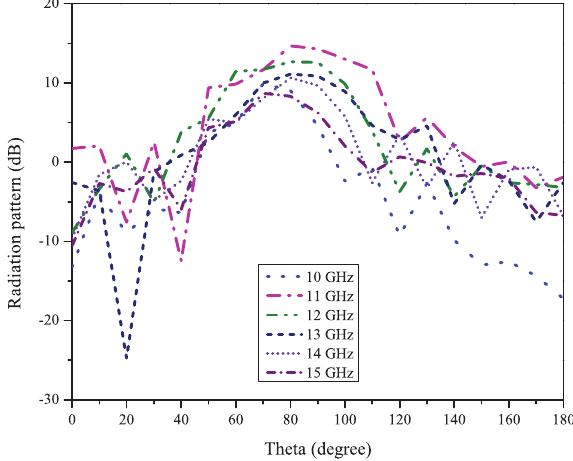
Figure 12. Radiation pattern of the proposed waveguide-SSPP design.